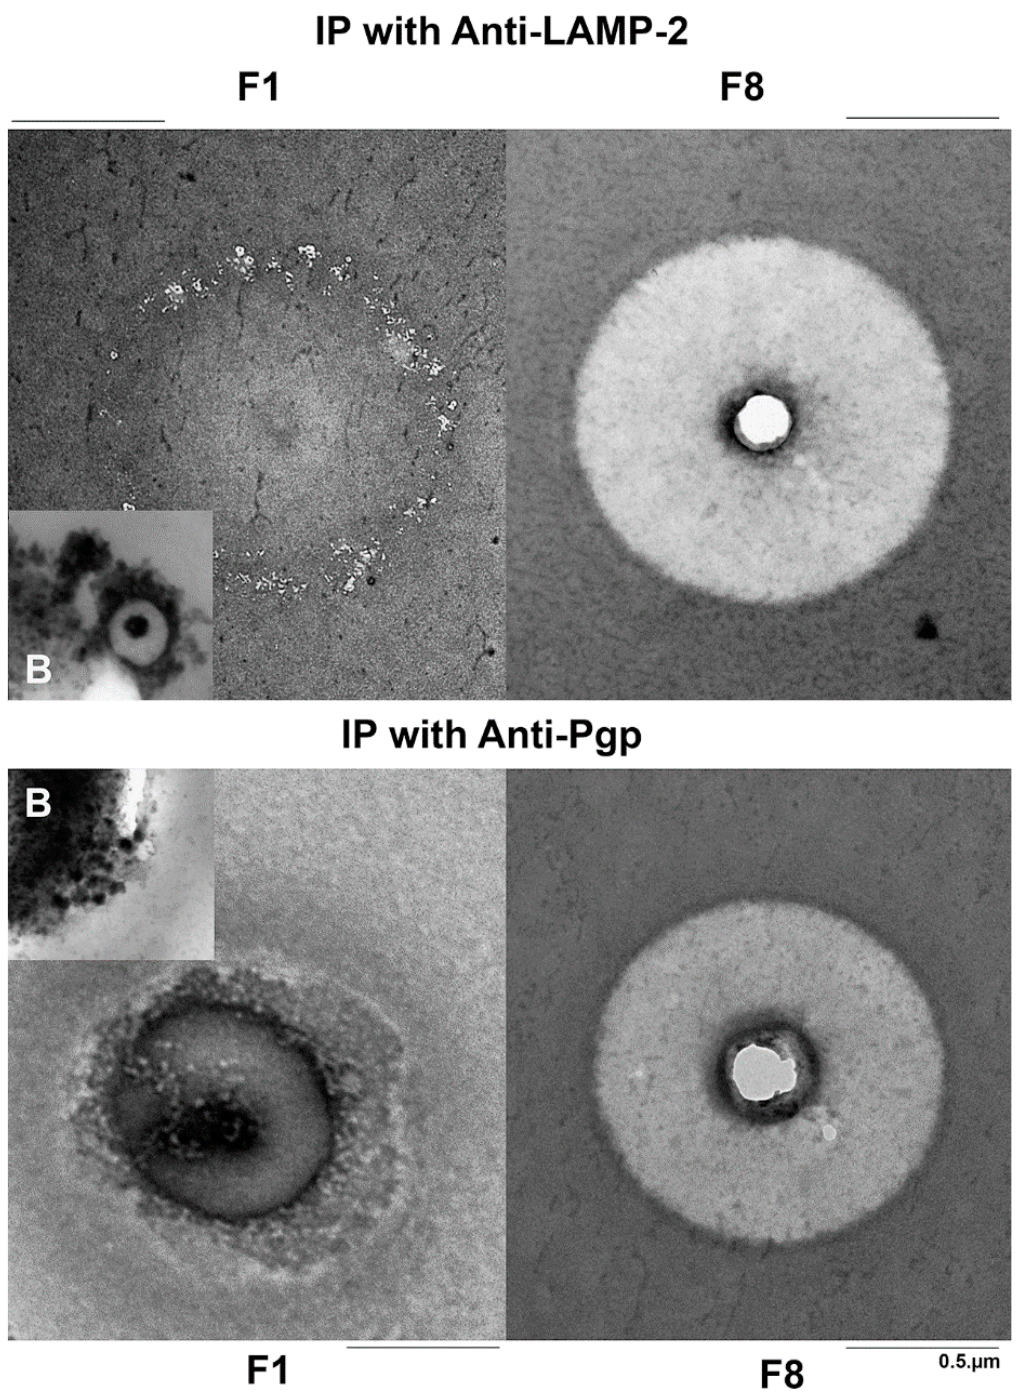
Figure 7. Ultrastructure of anti-LAMP-2 and anti-Pgp immunopurified vesicles. For immunopurifi- cation, beads coupled either to an antibody against LAMP-2 or Pgp were used and washed. After negative staining with uranyl acetate, no vesicular structures could be seen in F8, which was included as a negative control. In contrast, in F1 50 nm small LAMP-2 positive vesicles were present on the bead after negative staining. In thin sections of Epon-embedded preparations, multivesicular bodies (MVBs) with a size of about 500 nm were bound to the bead (B) as shown in the inset. When using beads coupled to an antibody against Pgp, only small (about 50 nm) Pgp immunopurified vesicles were isolated and were visible both in the negatively stained and the thin-sectioned beads (inset). In part, these vesicles formed tubular or net-like